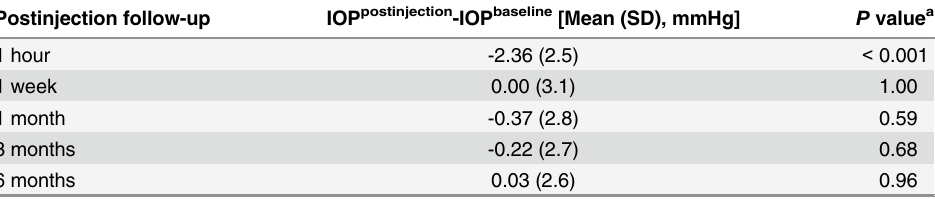
Table 2. The mean of IOP difference from baseline IOP at each visit after receiving treatment. Postinjection